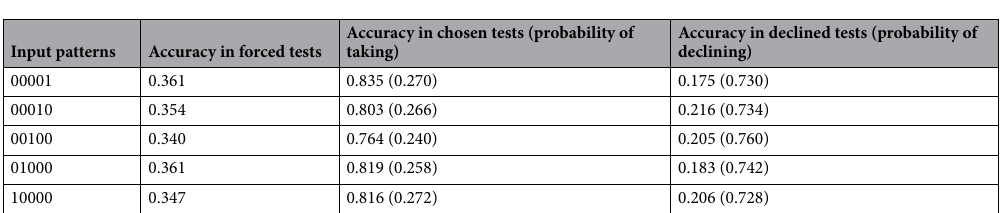
Table 1. Accuracy for each input pattern in each case ( delay = 40